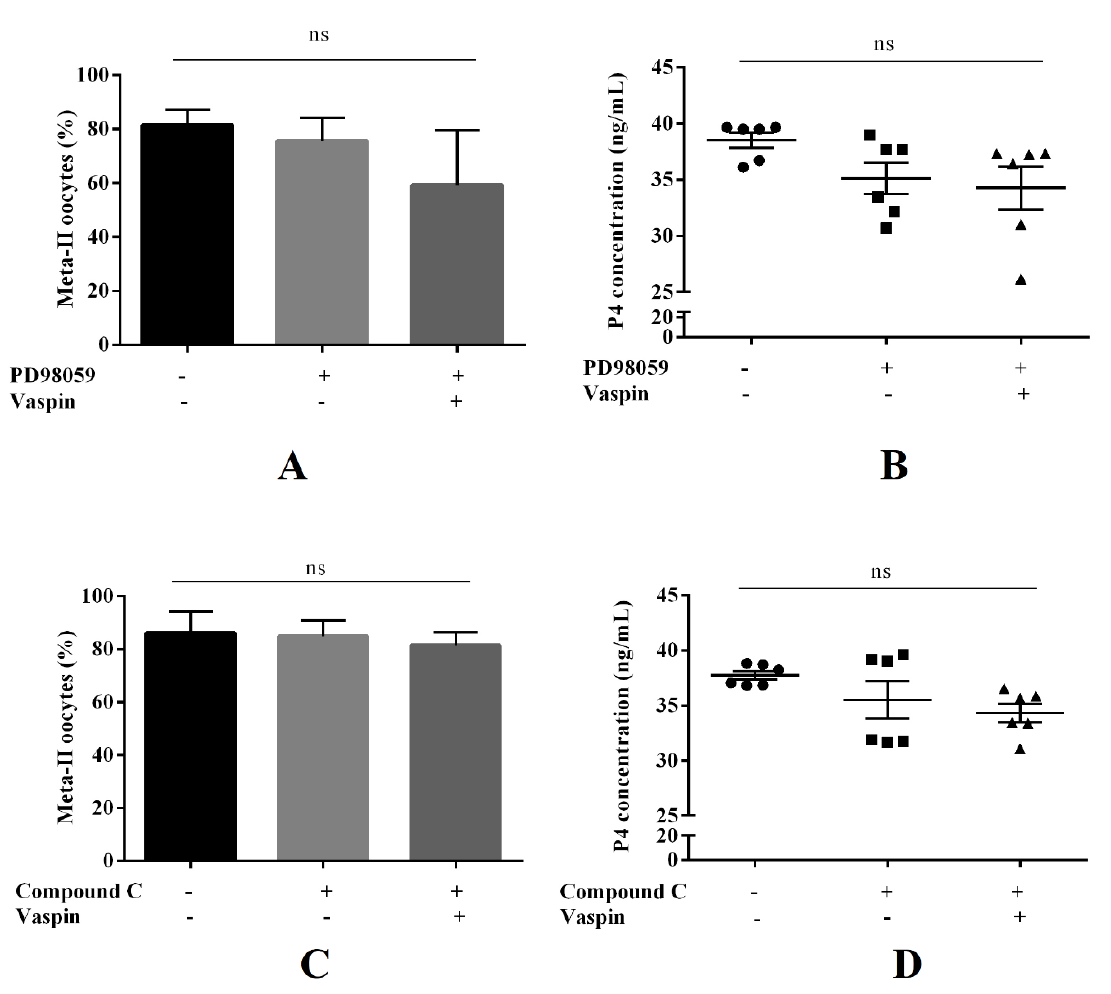
Figure 4. Involvement of the mitogen-activated kinase (MAP3 / 1) and AMP-activated kinase (PRKAA1) in the e ff ect of vaspin on in vitro oocyte maturation. COCs (50 / group / experiment) were selected after morphological examination of material collected from the ovaries taken from 100 pigs (15 follicles / ovary). Porcine cumulus–oocyte complexes (COCs) were cultured for 44 h in maturation medium with PD98059 (100 µ M), MAP3 / 1 kinase inhibitor or Compound C (1 µ M), PRKAA1 kinase inhibitor alone or with vaspin (1 ng / mL). The COCs were separated mechanically into oocyte and cumulus cells and nuclear maturation stages analysed by DAPI staining ( A , C ), while the medium was collected and progesterone (P4) level measured by ELISA ( B , D ). Experiments were performed independently and repeated three times ( n = 3). Data are plotted as the mean ± SEM of three independent experiments. Statistical analysis was carried out at p < 0 . 05; metaphase-II of meiosis (meta-II), no significant (ns).